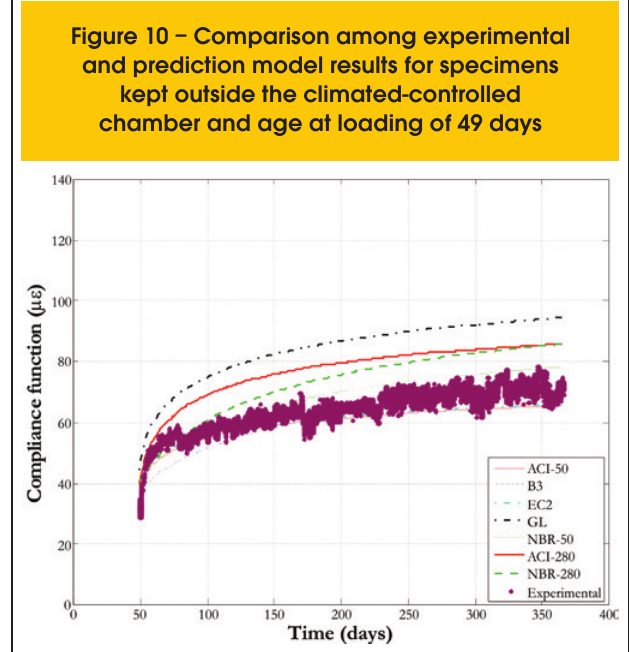
Figure 10 – Comparison among experimental and prediction model results for specimens kept outside the climated-controlled chamber and age at loading of 49